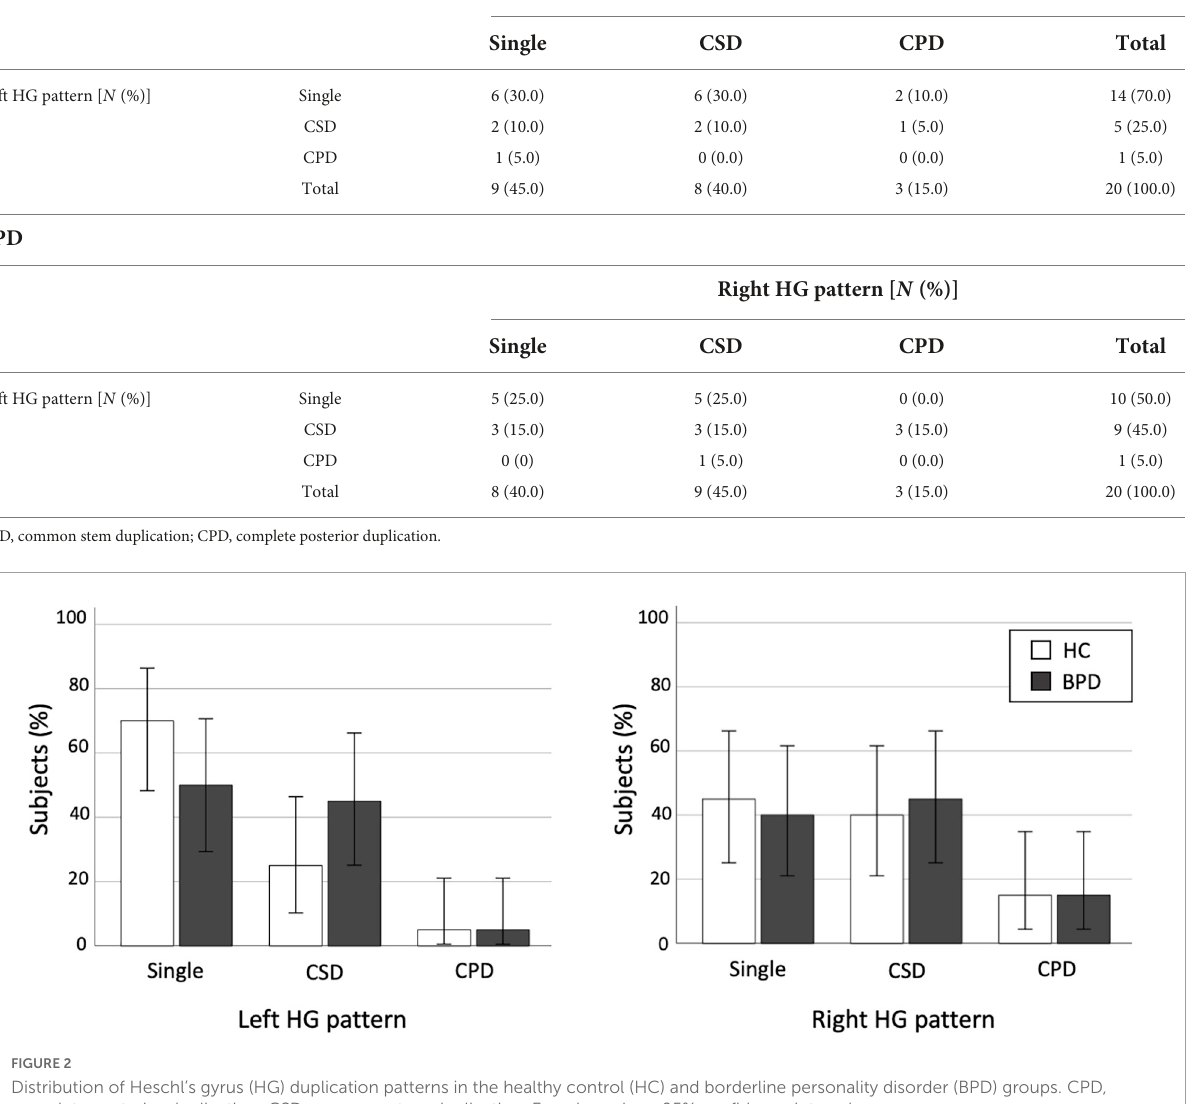
41). The BPD group was characterized by higher prevalence subjects (30%) [odds ratio = 2.33 (95% CI, 0.64–8.54)]